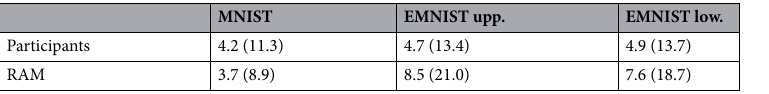
Table 2. Comparison of efficiency between our participants and the RAM model in terms of the average number of samples required to recognize a numeral/alphabet. Percentage of image area observed is included in parenthesis.